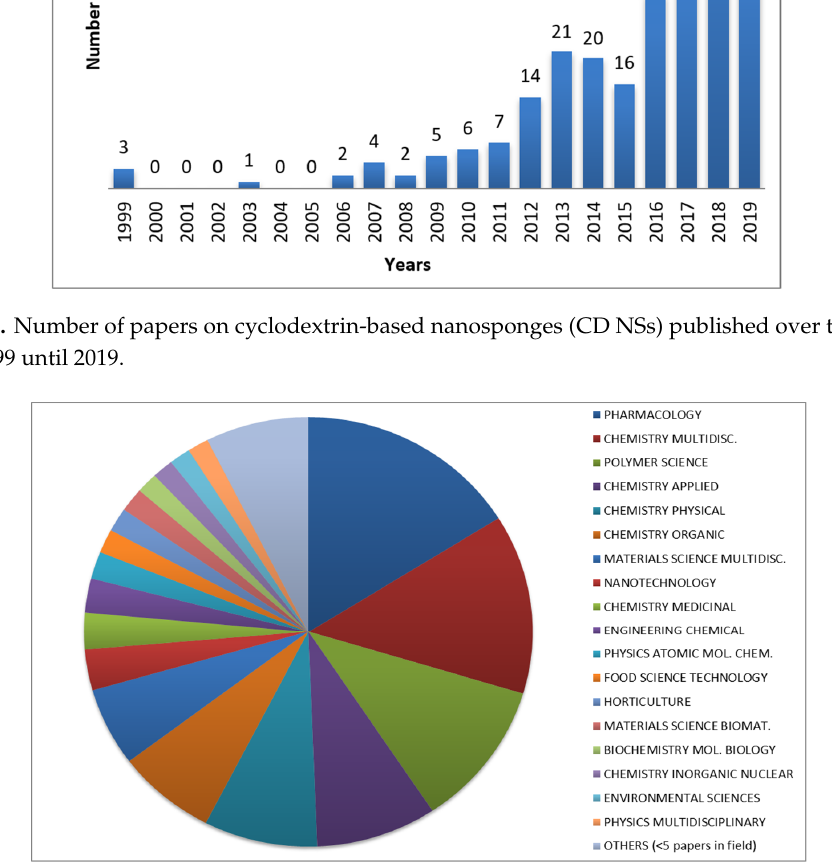
Figure 2. Research areas in which CD NSs are involved.